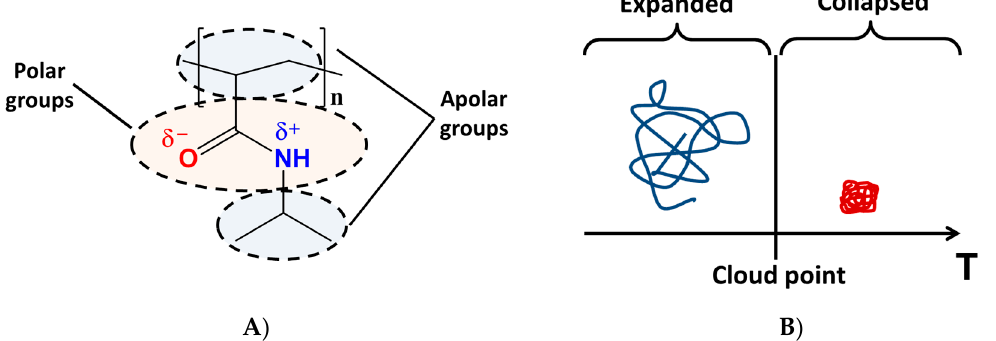
Figure 2. ( A ) Chemical formula of PNIPAAm and ( B ) Representation of volume phase transition between coil ( left ) and globular ( right ) hydrogel conformations.